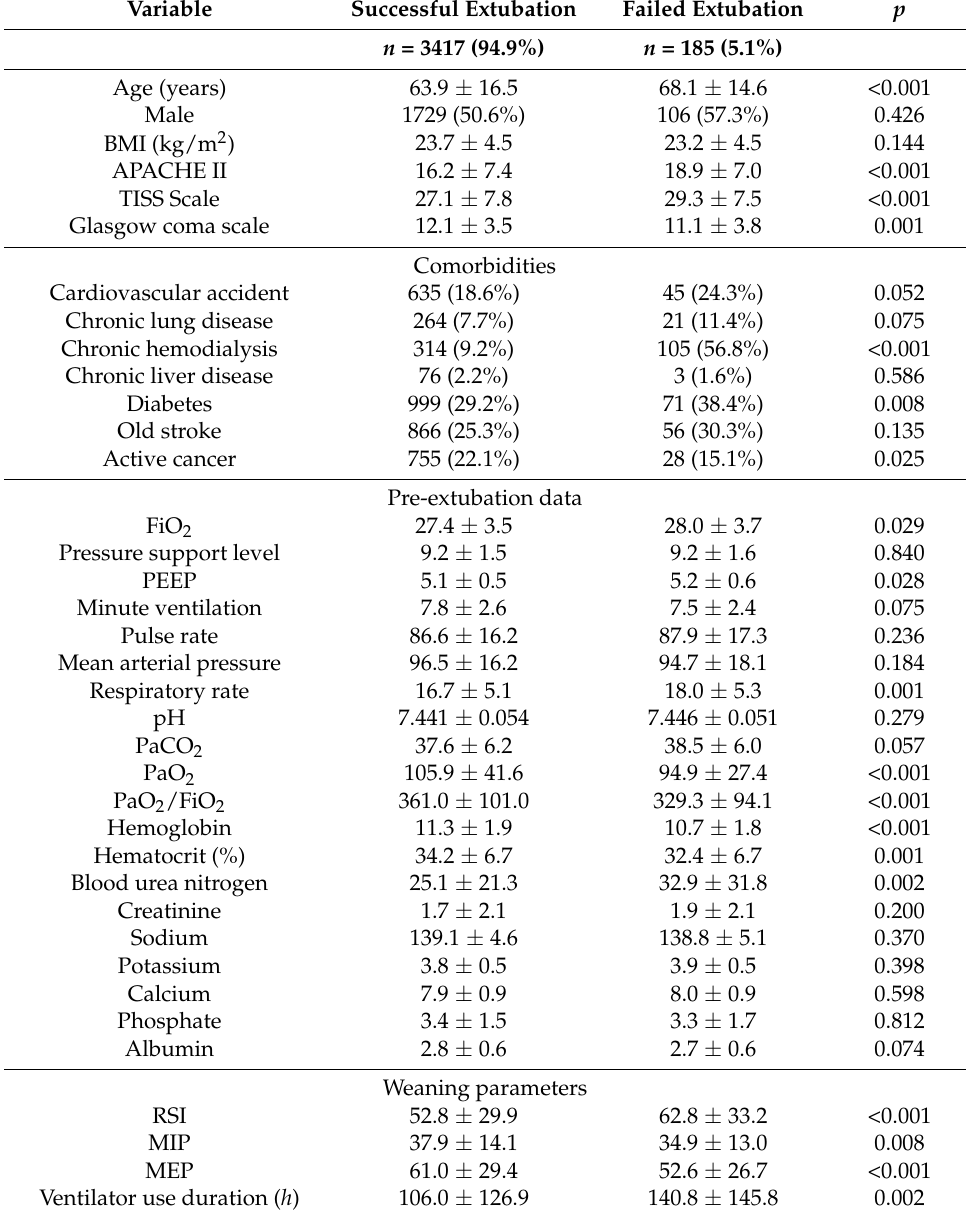
Table 1. Demographic and clinical characteristics of 3602 intensive care unit (ICU) patients with planned